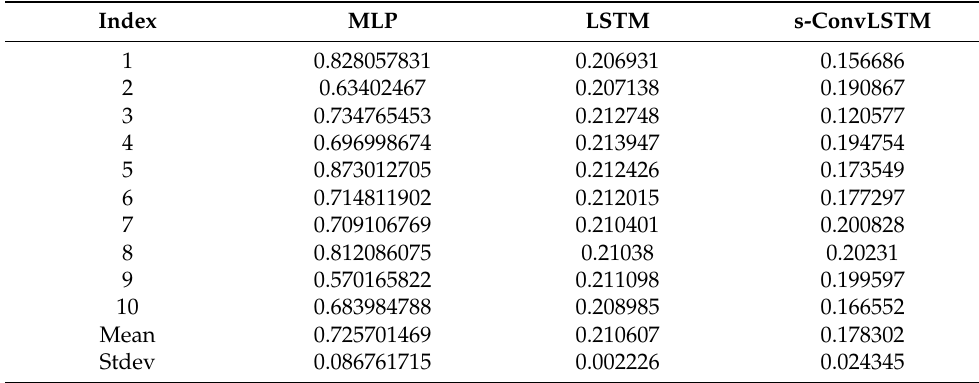
Table 5. Experiment results (RMSE).